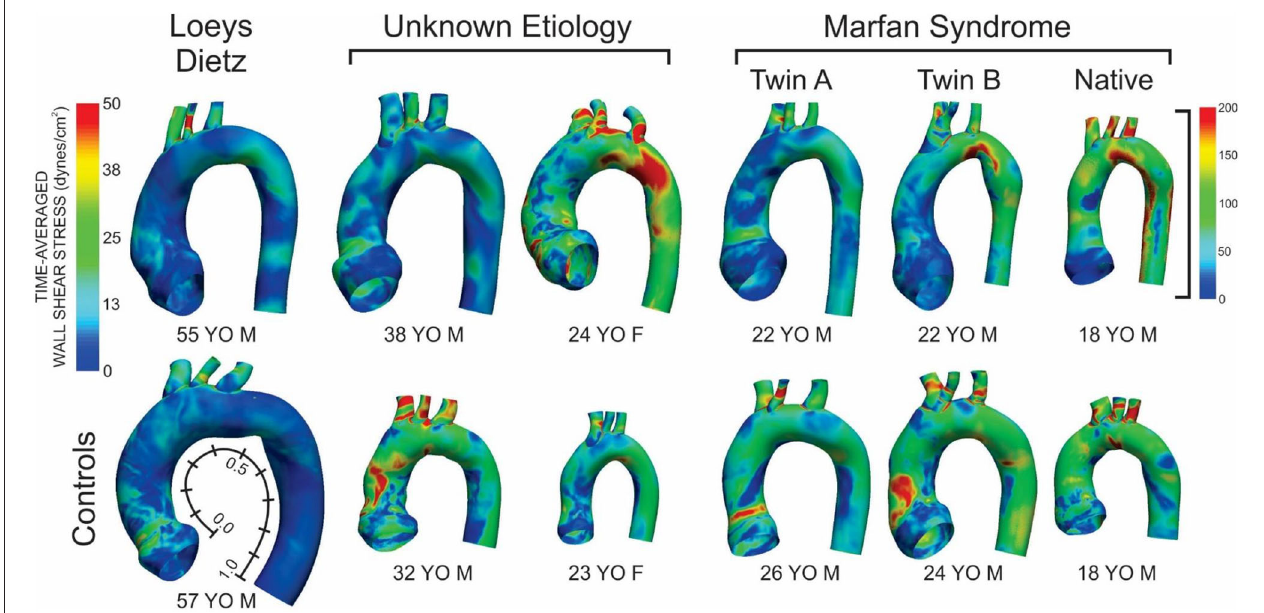
FIGURE 1 | Time-averaged wall shear stress (TAWSS) distributions for the six patients with the various connective tissue diseases studied (top row) and age- and gender-matched control participants to which each was compared (bottom row). The size of the models displaying the TAWSS results shown is relative to each other using the descending aortic outlet dimensions. Data in Figures 2 , 4 are presented along the length of the aorta. This distance was made consistent between patients and control participants using dimensional information from imaging data and then normalized from 0 to 1 as shown beside the model and TAWSS from the leftmost control